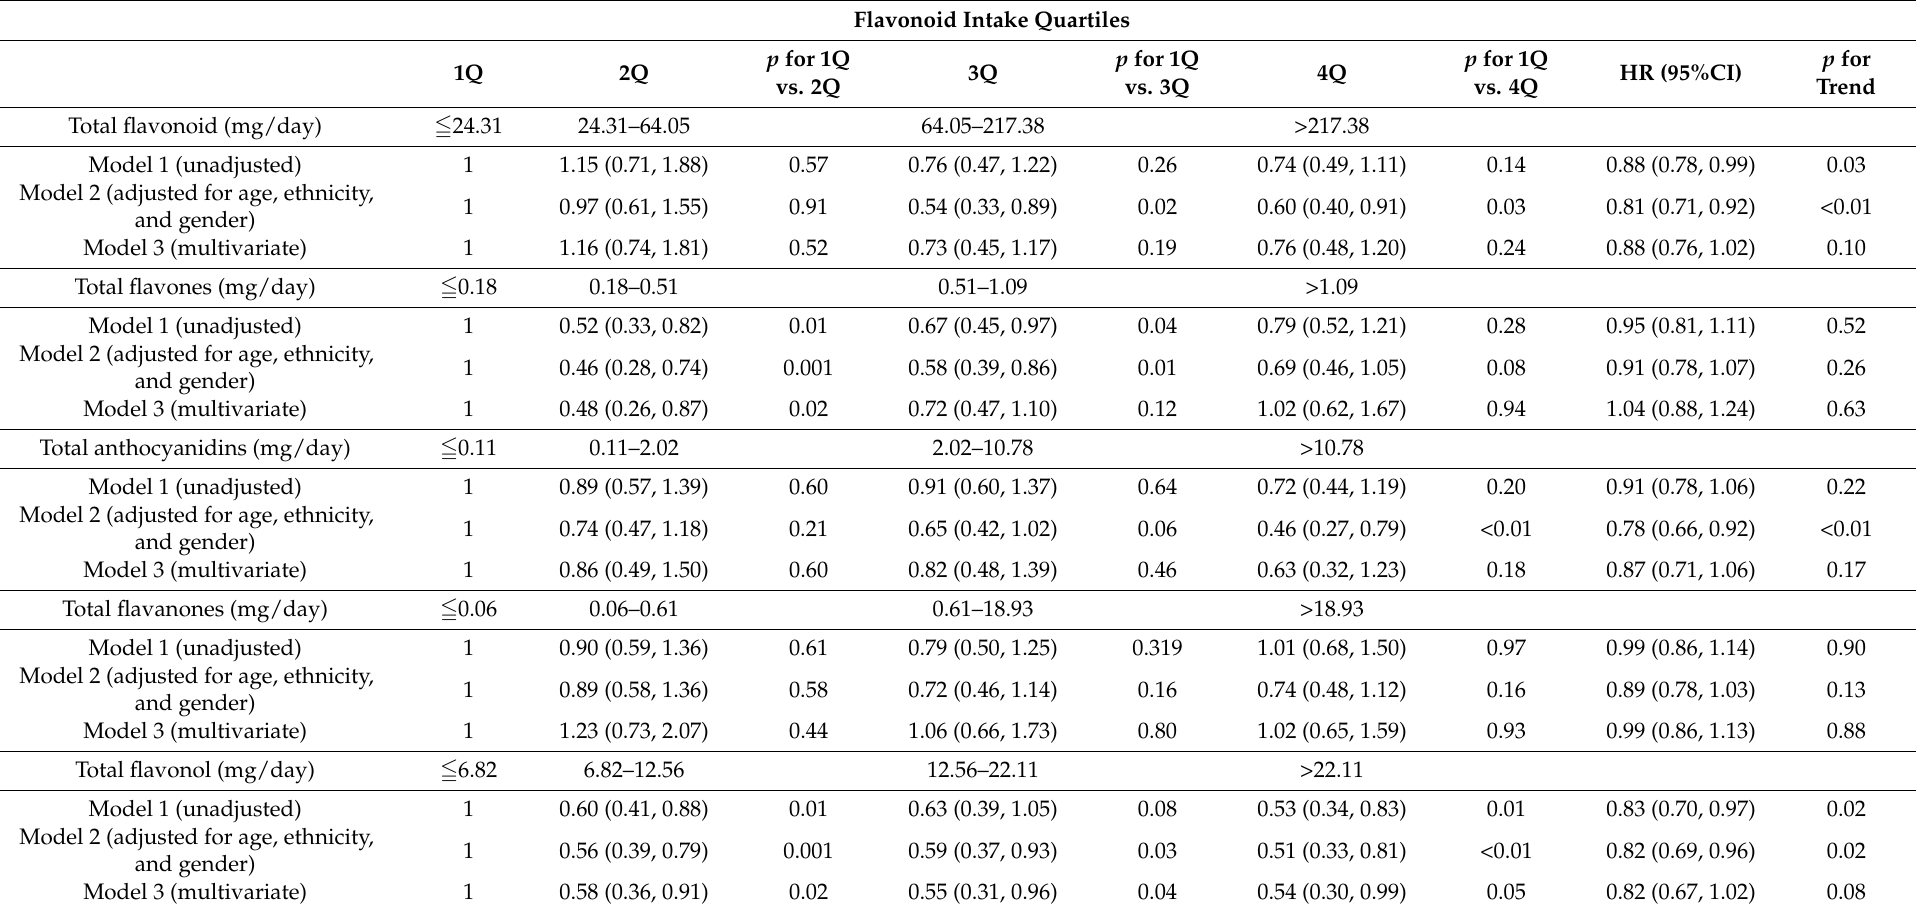
Table 5. Hazard ratios of cancer mortality by quartiles of dietary flavonoid